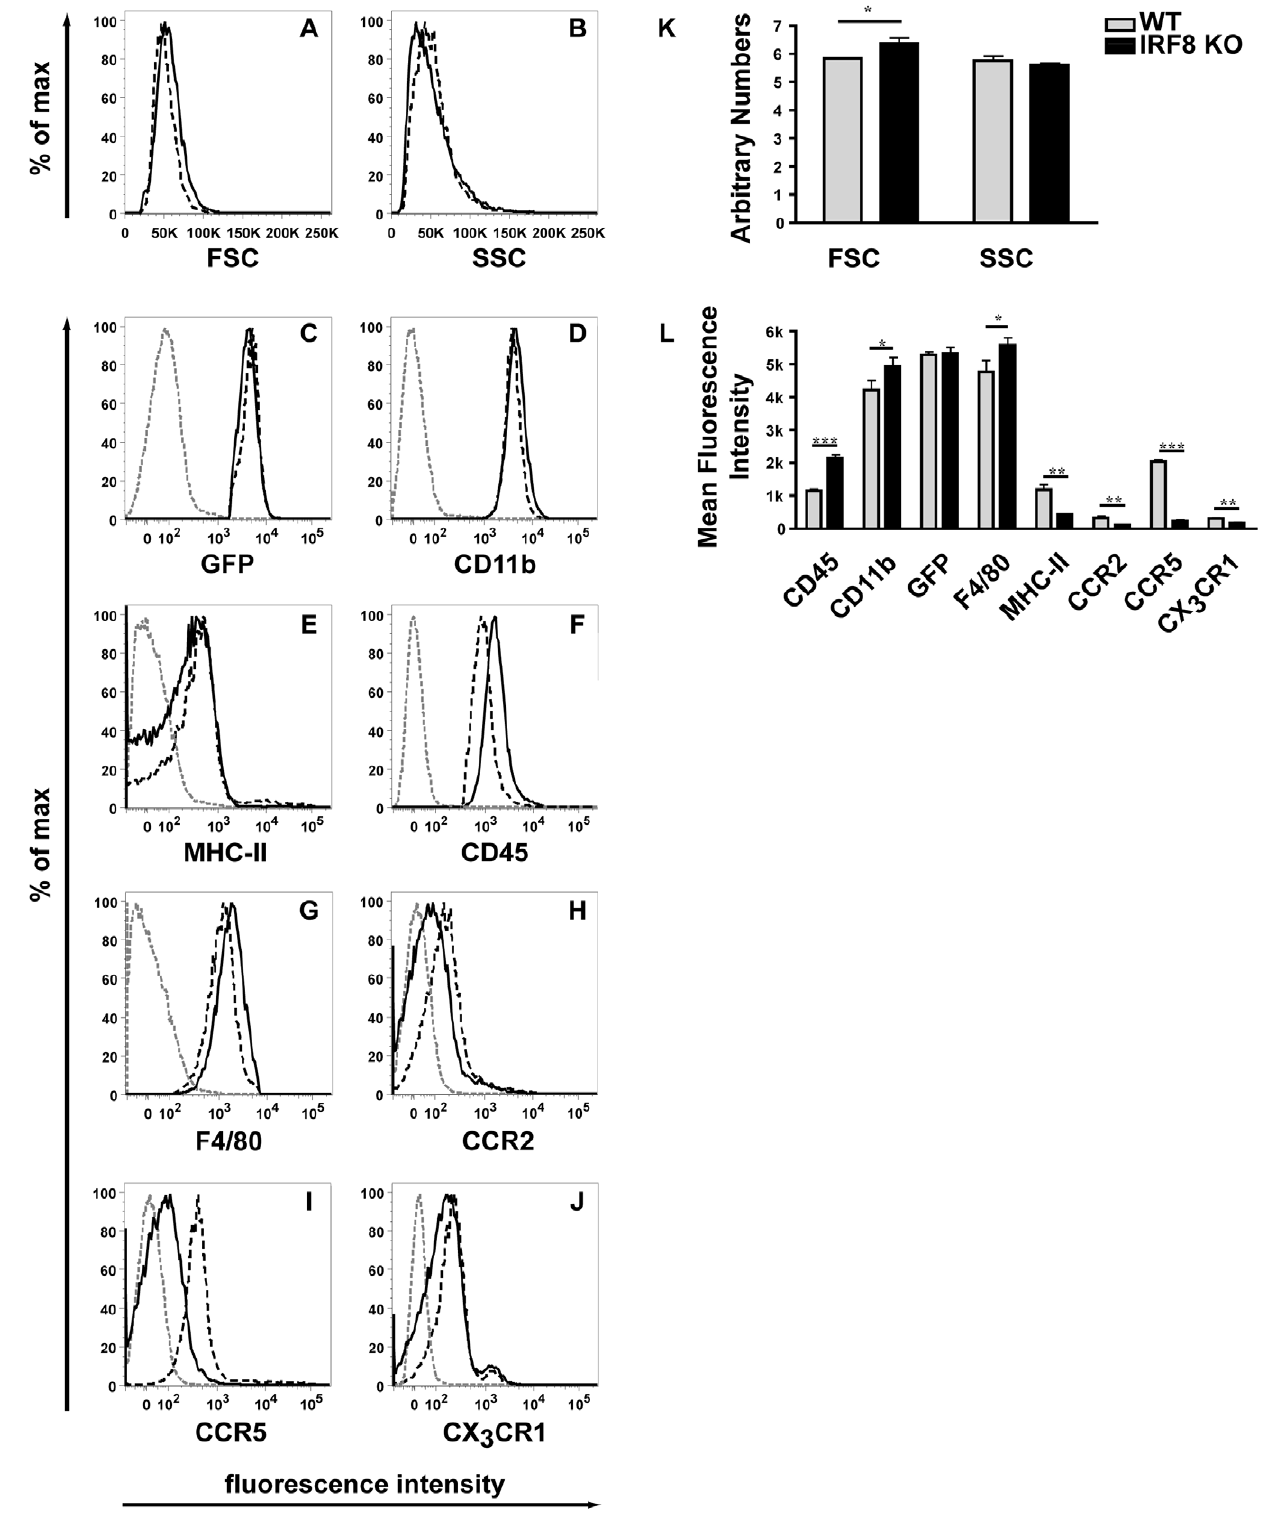
Figure 5. Surface levels of various molecules are altered on IRF8-deficient microglia. Flow cytometry (A-J) was performed on microglial cells isolated from the brain of adult WT (black dashed line) and IRF8-deficient (black line) mice as described in the Materials and Methods. For analysis, cells were scatter-gated to exclude dead cells and were selected for GFP, CD11b expression. An isotype matched antibody was used as a negative control (grey dashed line). Quantification of forward and sideward scatter; (K) or mean fluorescent intensity of histograms (L). The histograms represent means + / 2 SD from three separate experiments. For significance: ***P , 0.001, **P , 0.01, *P , 0.05; by two-tailed t-test.